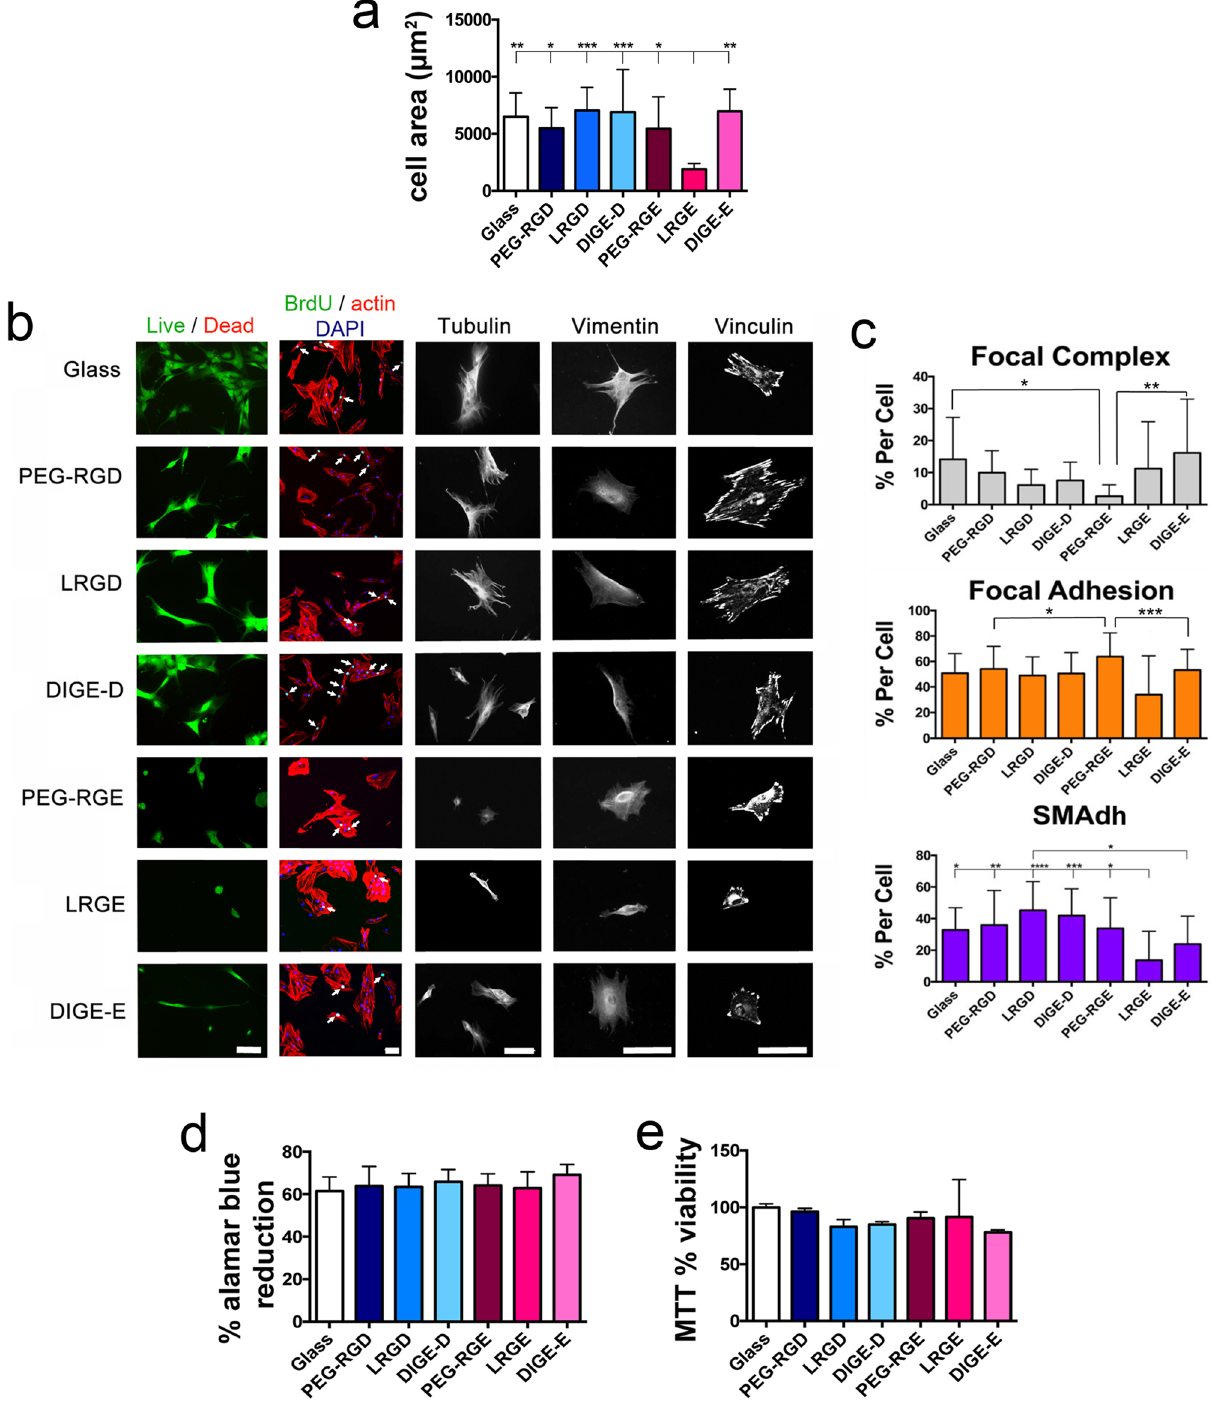
Figure 4. SSC biocompatibility. ( a ) Cell area measurements after 24 h of culture on the samples showing that RGD containing surfaces and DIGE-E supported similar cell spreading compared to glass while LRGE, where the RGE was exposed, reduced SSC spreading (n = 15). ( b ) Viability, proliferation and cytoskeletal analysis showed high cell viability on all surfaces. Growth and cytoskeletal organisation were reduced on the LRGE surface and PEG-RGE surface where the RGE group was exposed. ( c ) Focal adhesions were categorised as FC (< 2 µm), FA (2–5 µm) and SMAdh (> 5 µm) and expressed as % total adhesions (n = 15). The main difference to indicate cells responding to the PEG cleavage was seen in the SMAdhs, where LRGD and DIGE-D gave the largest differences to the RGE containing surfaces. ( d ) Alamar blue and MTT metabolic assays showing no differences (n = 3). Graphs show mean ± SD, statistics by ANOVA and Tukey test where *p < 0.05, **p < 0.01, ***p < 0.001 and ****p < 0.0001. If stars are not shown on the graphs, it denotes no significant difference was observed between the treatment and relevant control. Please note that SSCs purchased from Promocell GMBH rather than stro-1 +ve cells were used to create this